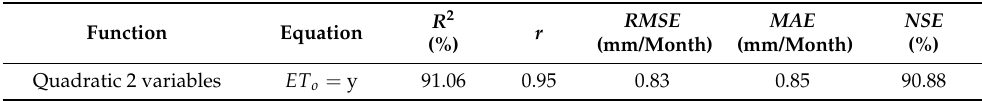
Table 7. Results of the GMDH for ET o estimation at the best function (Appendix